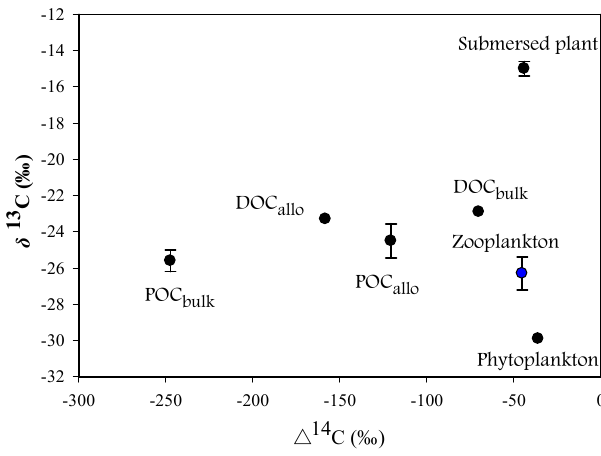
Figure 2. Isotope bi ‐ plots of zooplankton and its potential food sources in Lake Nam Co.